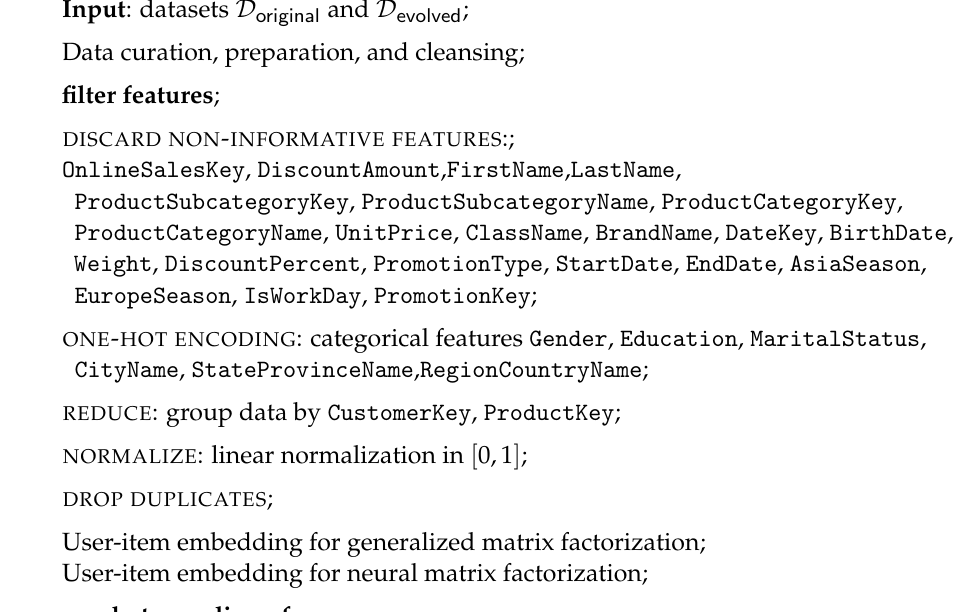
Algorithm 2: Processing steps for data analysis,